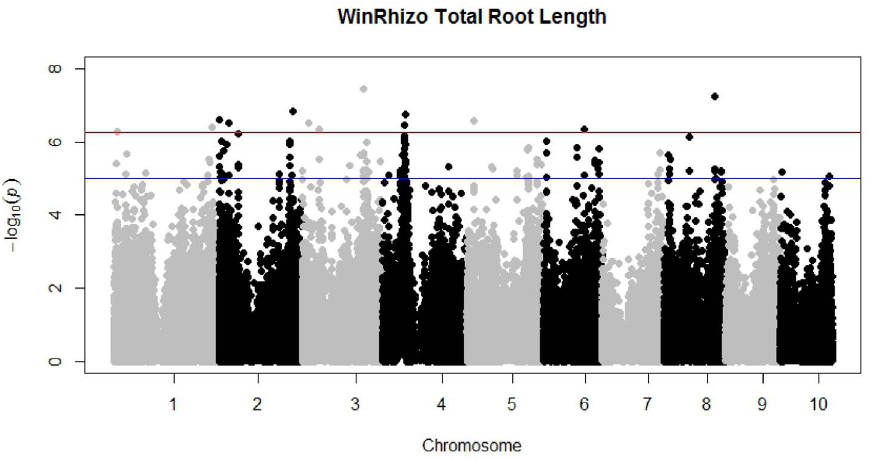
Figure 4. Manhattan plot displaying all 10 maize chromosomes, showing SNP markers significantly associated with trait Total Root Length measured with WinRhizo, significant SNPs are consistent with ARIA , with additional SNPs on chromosomes 3, 5, 6, and 8.